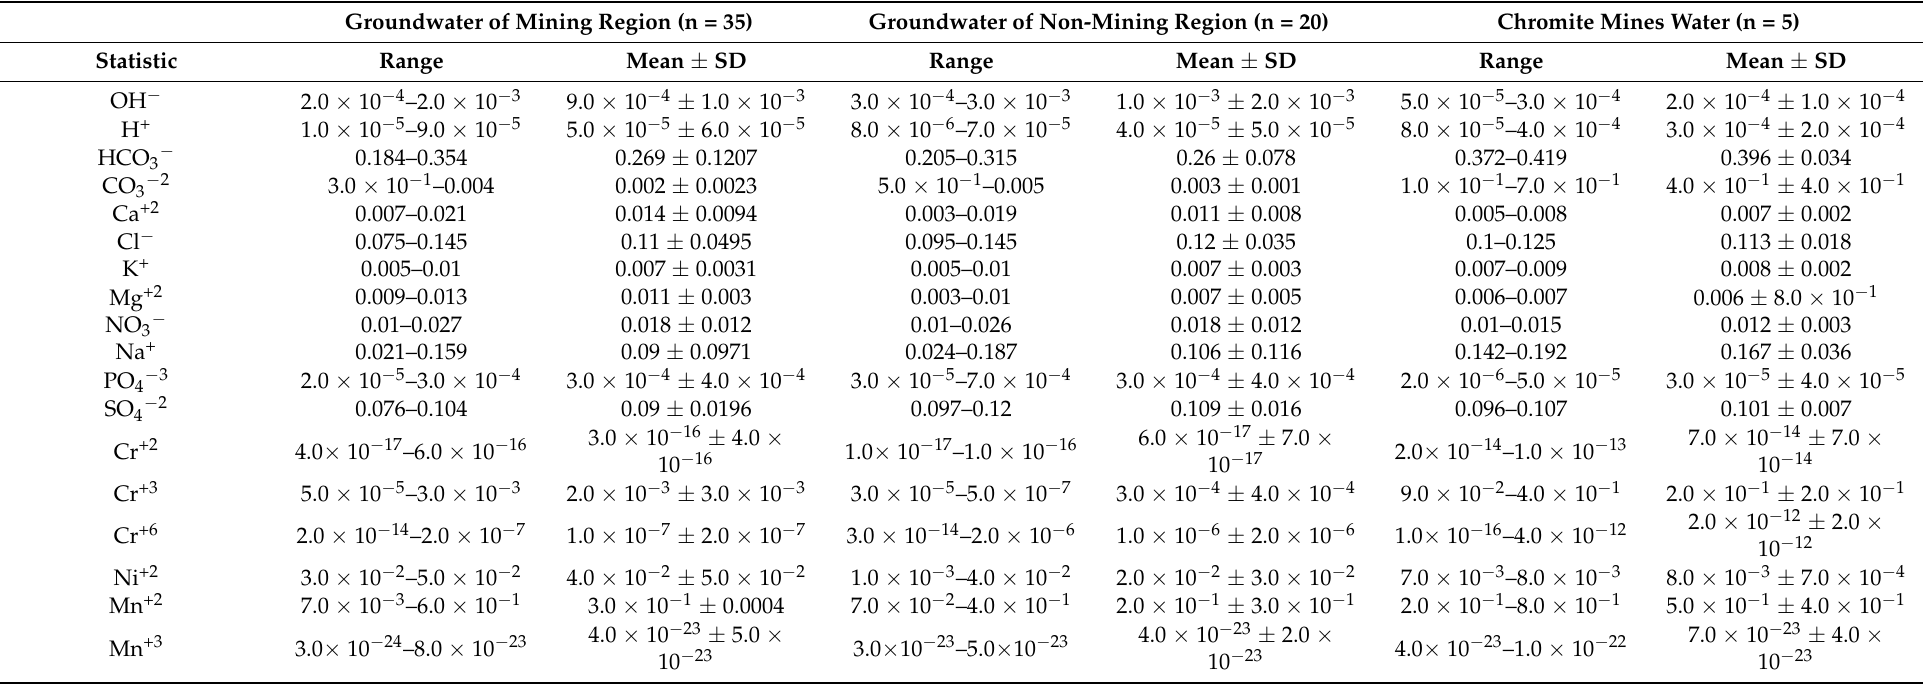
Table 4. Chemical speciation in groundwater sources of mining and non-mining region and their comparison with chromite mine water in the ultramafic terrain of Malakand, Northern